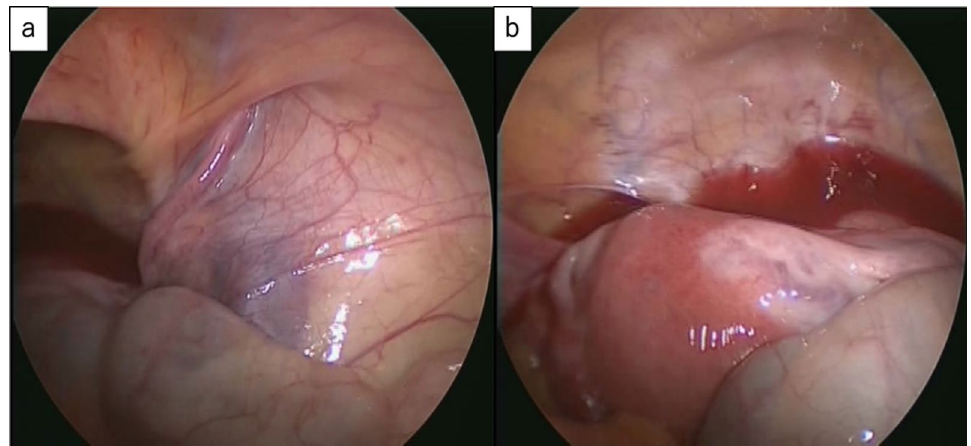
Fig. 2 a Inguinal hernia that required treatment was not found on laparoscopic observation of the abdominal cavity. b Bloody ascites suggestive of endometriosis was found in the pouch of Douglas